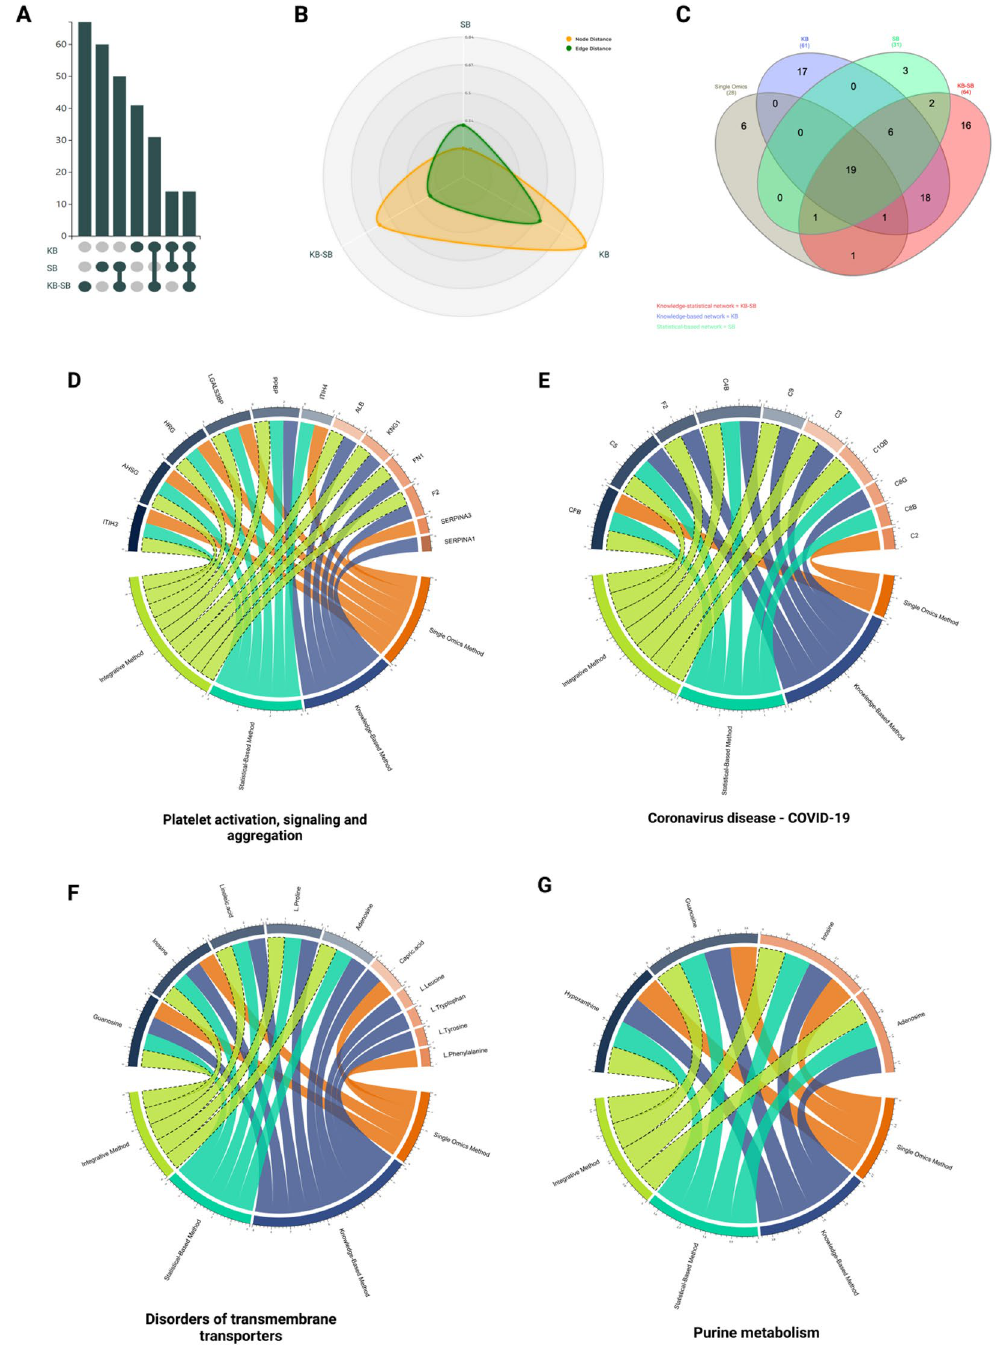
Figure 5. Networks comparative analysis and pathways tracking analysis. ( A ) UpSet plot comparing node size of each network generated from different omics method. The knowledge-statistical network (KB-SB) has the largest node size with 43 proteins and 24 metabolites. Meanwhile, the knowledge-based network (KB) has the smallest node size with 23 proteins and 18 metabolites and also revealed 14 overlapped features in the intersection between the knowledge-based and statistical-based networks. ( B ) Radar plot shows the similarity between the networks on both node and edge levels based on the distances between them, the node distance is highlighted in green and the edge distance is highlighted in yellow. ( C ) Significant pathways (FDR < 0.05) uncovered by each method were compared to each other and represented by the Venn diagram. ( D–G ) Four pathways were further tracked for a better understanding of how far each method can see inside the pathway, including ( D ) platelet activation, ( E ) coronavirus disease, ( F ) disorders of transmembrane transporters pathways, and ( G ) purine metabolism pathway. Each method was highlighted in a different color as illustrated in the chord